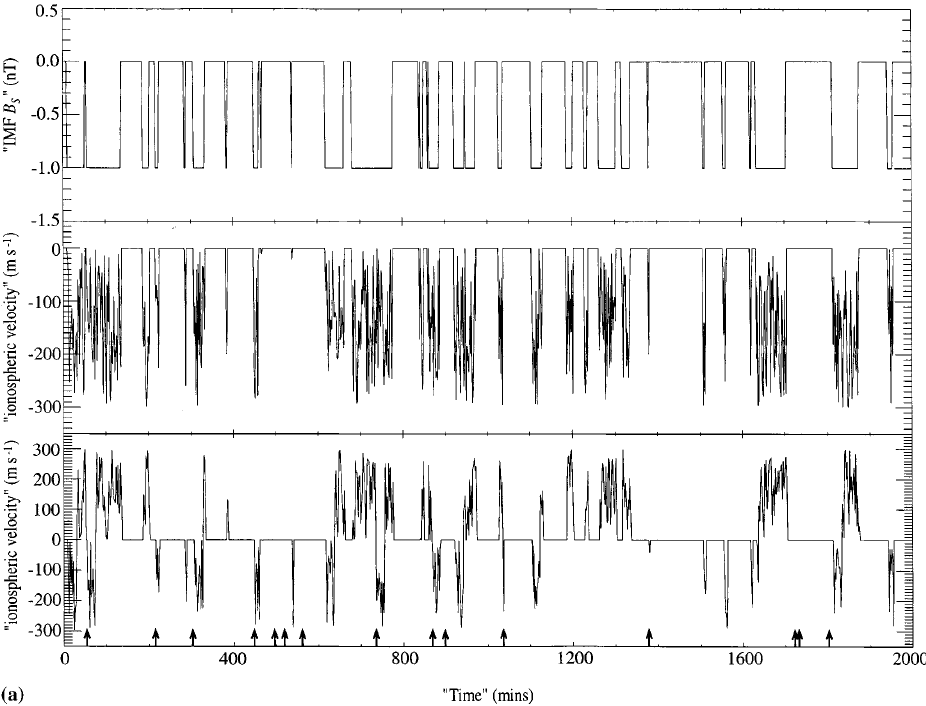
Fig. 3. a Synthetic data sets of 1000 2-min ‘‘IMF B ’’ values ( upper s panel ) and simultaneous ‘‘ionospheric velocity’’ components deter- mined from two di(cid:128)erent algorithms ( lower two panels ). In the upper panel, ‘‘IMF B ’’ is switched between zero and ) 1 nT (or vice versa) at s 75 randomly chosen times. In the middle panel the ‘‘velocity’’